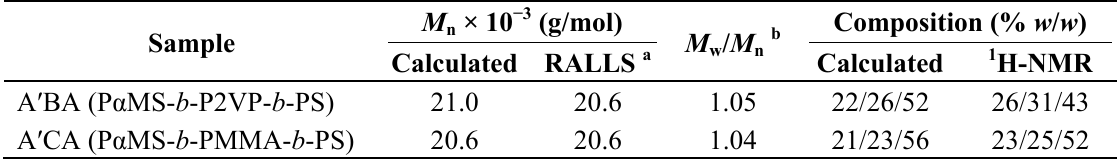
Table 6. Molecular characteristics of A ′ BA and A ′ CA triblock